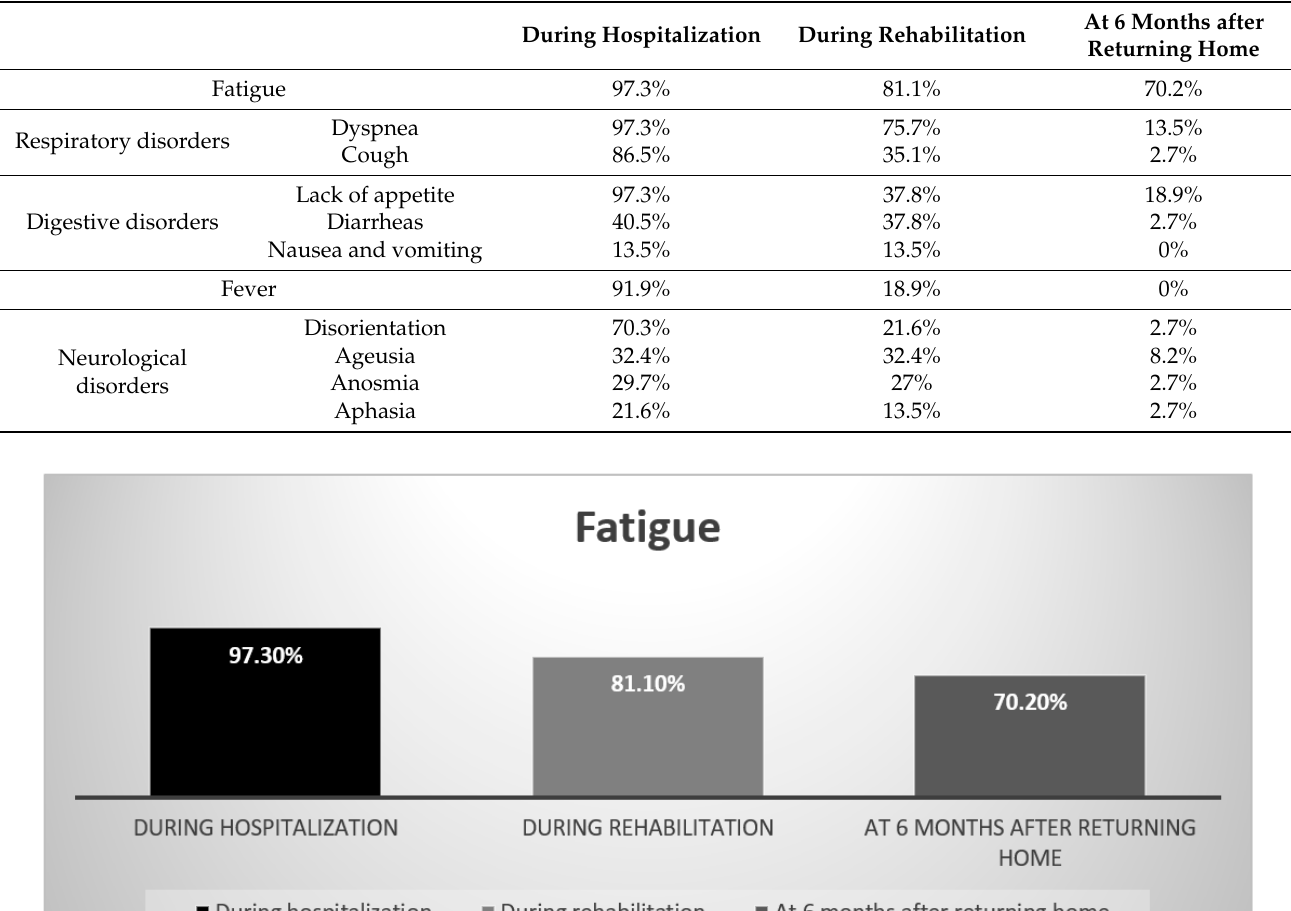
Table 4. Evolution of COVID-19 symptoms.